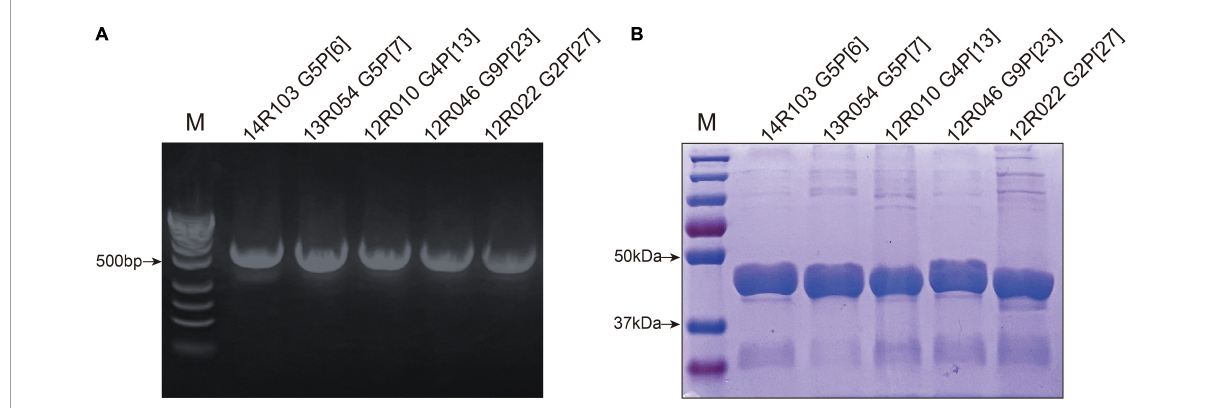
FIGURE2 Characterization of recombinant VP8 ∗ . (A) Amplification of target fragments 498 bp from fecal samples, (lane M = standard molecular weight marker). (B) The SDS-PAGE of the GST-VP8 ∗ fusion proteins (Lane M = blue prestained protein standard). The 26 kDa band represents free GST.